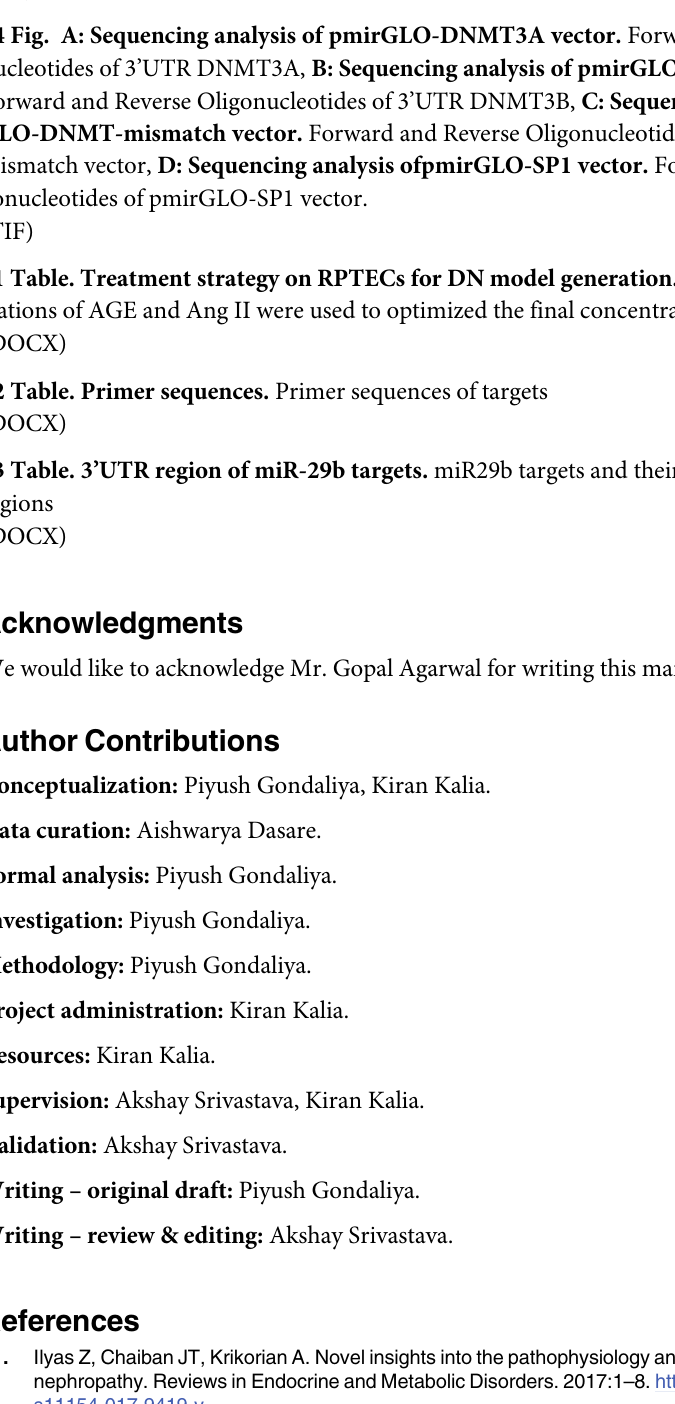
S4 Fig. A: Sequencing analysis of pmirGLO-DNMT3A vector. Forward and Reverse Oligo- nucleotides of 3’UTR DNMT3A, B: Sequencing analysis of pmirGLO-DNMT3B vector. Forward and Reverse Oligonucleotides of 3’UTR DNMT3B, C: Sequencing analysis of pmir- GLO-DNMT-mismatch vector. Forward and Reverse Oligonucleotides of pmirGLO-DNMT- mismatch vector, D: Sequencing analysis ofpmirGLO-SP1 vector. Forward and Reverse Oli- gonucleotides of pmirGLO-SP1 vector. S1 Table. Treatment strategy on RPTECs for DN model generation. Three different concen- trations of AGE and Ang II were used to optimized the final concentration for treatment. S2 Table. Primer sequences. Primer sequences of targets S3 Table. 3’UTR region of miR-29b targets. miR29b targets and their respective 3’UTR